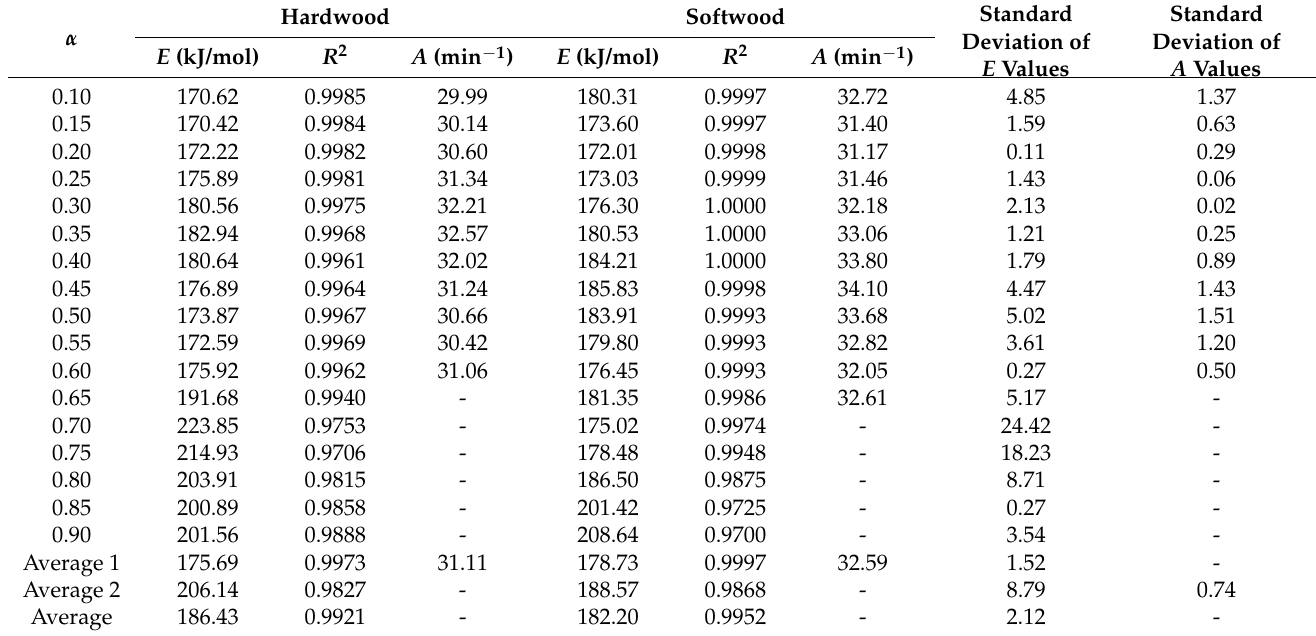
Table 3. E , A , and R 2 values for hardwood and softwood based upon the KAS